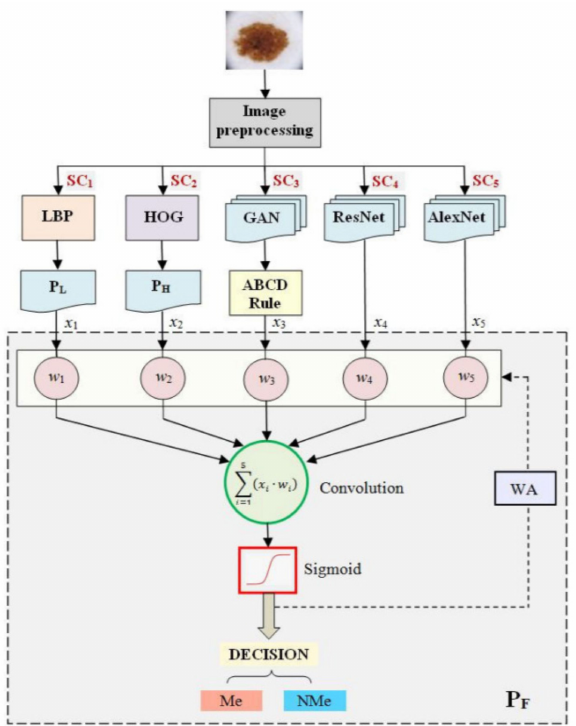
Figure 28. The architecture of the Me classification system proposed in [6], based on several NNs connected on two levels of